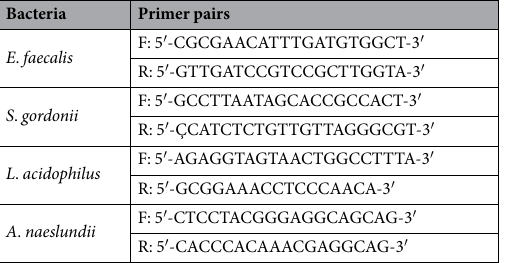
Table 1. The species specific primers used in qPCR to identify prevalence of individual bacteria in